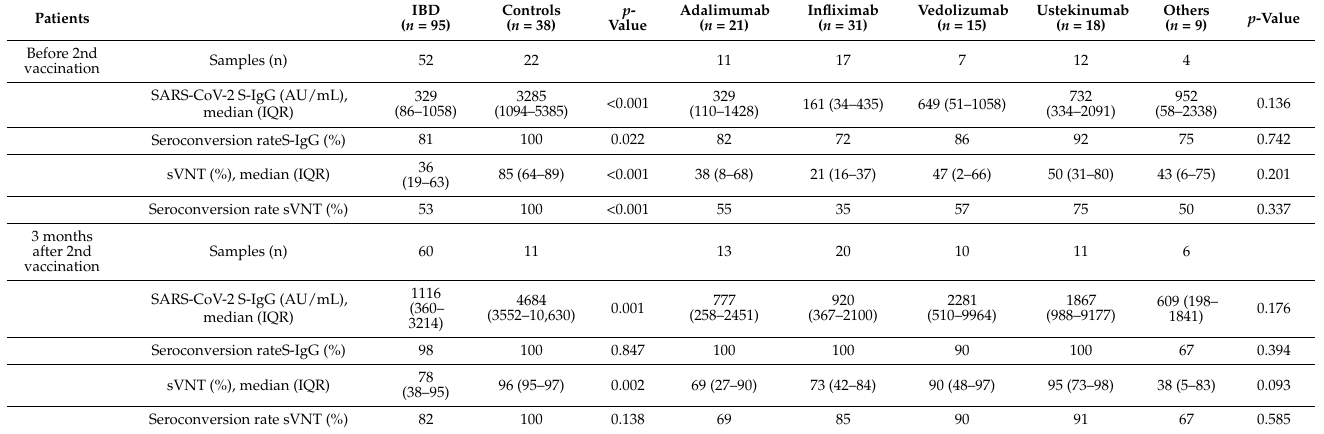
Table 2. SARS-CoV-2 S-IgG levels and sVNT values of IBD patients and healthy controls before the first and second vaccination, as well as 3 and 6 months after the second vaccination. Partitioning of the IBD patient population was completed based on immunosuppressive therapy (adalimumab, infliximab, vedolizumab, and ustekinumab). Other immunosuppressive therapies (corticosteroids, tofacitinib, certolizumab, golimumab, risankizumab, etrolizumab, mycophenolate mofetil, and aza- thioprine) were grouped under “others”. IBD: inflammatory bowel disease; IQR: interquartile range; vacc.: